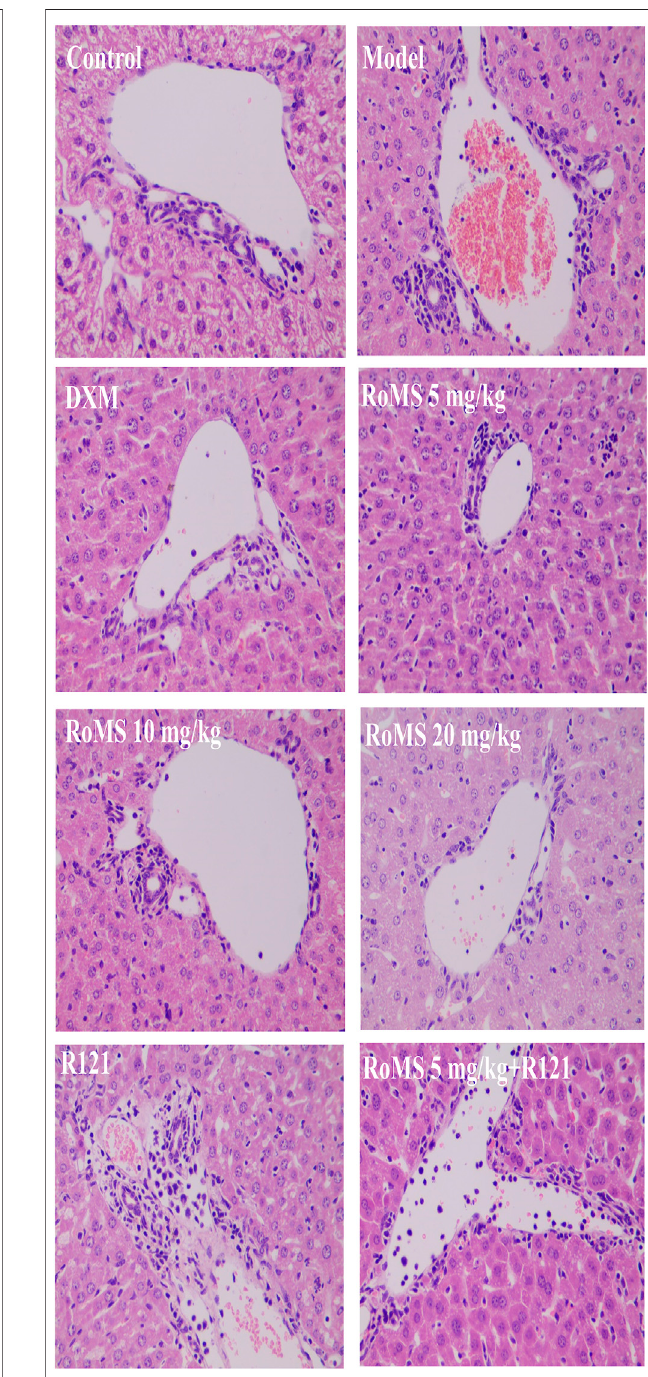
FIGURE 4 | Effect of RoMS (at 7 days after pre-administration) on liver injury in mice. Liver tissues were stained with H&E, ×400 magni fi cation.